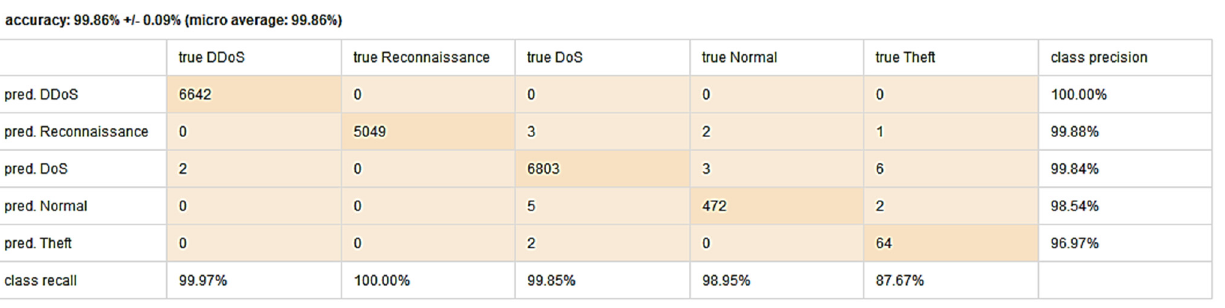
Figure 11. Confusion matrix of kNN-BE.